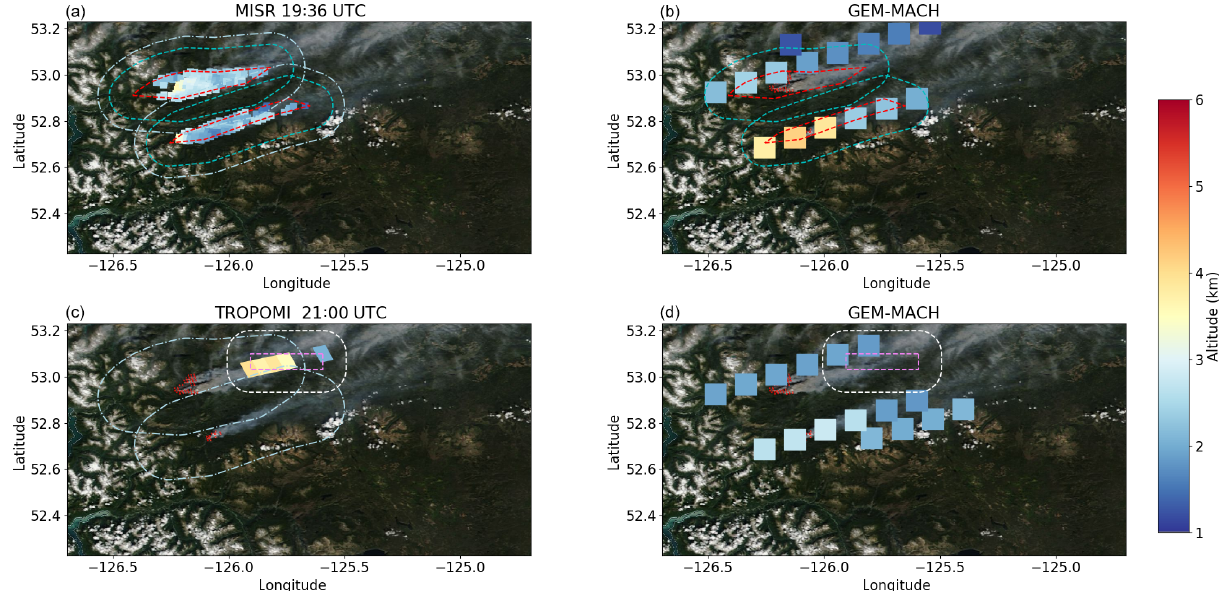
Figure 2. Example of two fire plumes on 6 August 2018 in British Columbia, Canada (approximately 56 ◦ N, 126 ◦ W). The colour scheme illustrates the altitude of the plume (a) as observed by MISR at 19:38UTC, (b) modelled in GEM-MACH using CFFEPS at 19:38UTC, (c) observed by TROPOMI at 21:00UTC, and (d) modelled by GEM-MACH using CFFEPS at 21:00UTC. The dashed lines outline the shape of the plume used for the comparison (see text for further details). (Underlying VIIRS images obtained from NASA Worldview (https://worldview.earthdata.nasa.gov/, last access: 25 March